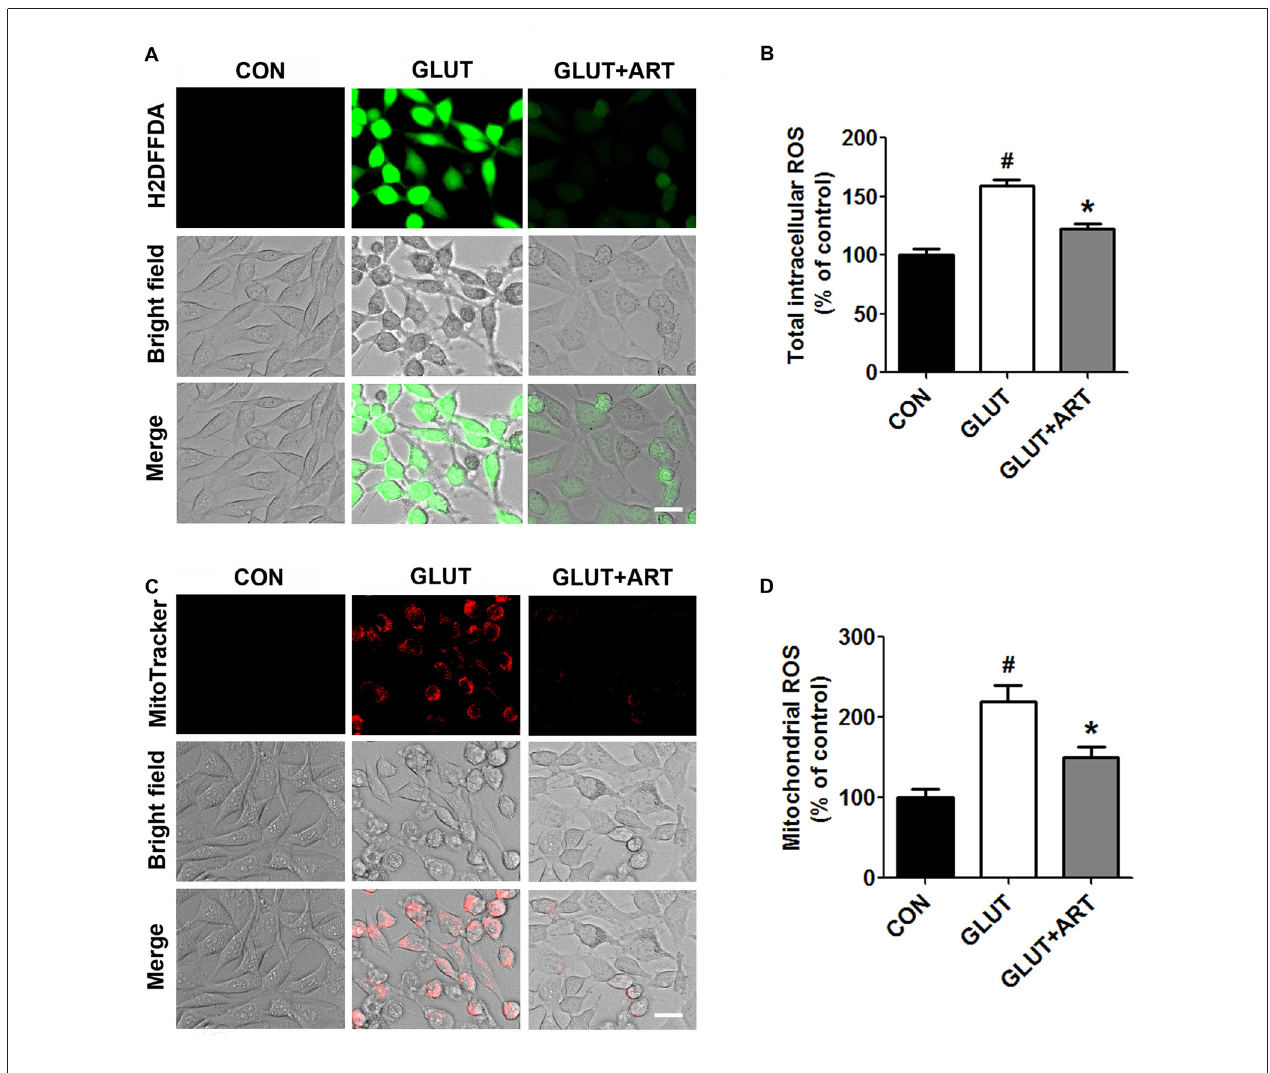
FIGURE 3 | Artemisinin decreased glutamate-induced oxidative stress in HT-22 cells. (A,B) Artemisinin reduced the increase of glutamate-induced total intracellular reactive oxygen species (ROS). (C,D) Artemisinin decreased the elevation of glutamate-induced mitochondrial ROS. Scale bar = 20 µ m. # p < 0.05 vs. CON group, ∗ p < 0.05 vs. GLUT